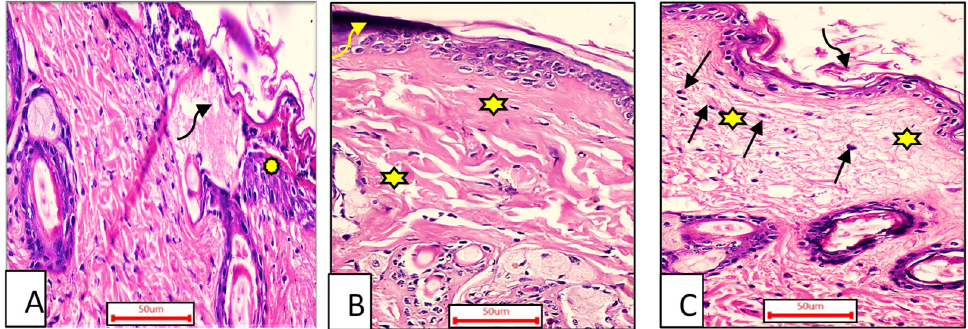
Figure 7. A sample of the wounded skin of individuals from each treatment group seven days after incision; Group I ( A ) showing the typical wound margin with the normal epidermis (asterisk). The wound was clogged with blood clots and granulation tissue (curved arrow). Group II ( B ) blood clot seen above the incision visible (curved arrow). Compactly arranged dermal collagen fibers are seen (aster). Group III ( C ) scar tissue (curved arrow) blocked the incision, and collagen fibers (stars) resembled the neighboring normal dermis with inflammatory cellular activity, particularly macrophages (black arrows). (H & E stain ×